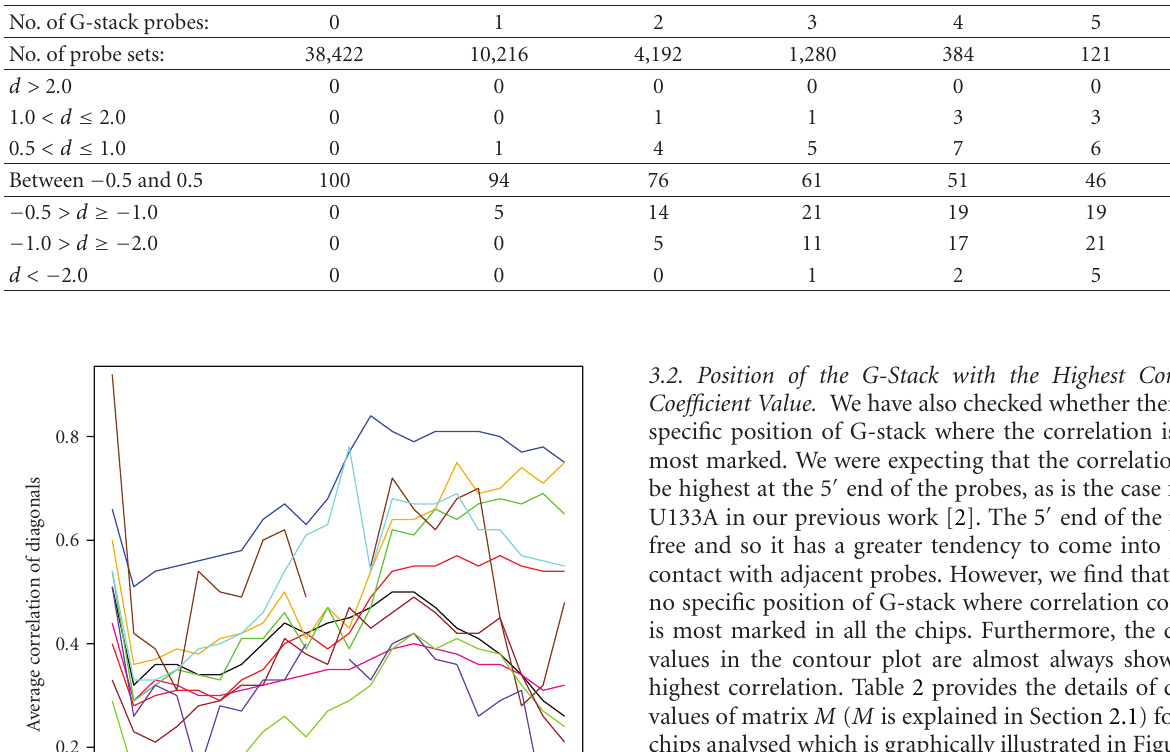
Table 3: The e ff ect on RMA of removing G-stack probes from probe sets. Subtraction of the original RMA value from the RMA value after removal of G-stack probes gives the quantity d . Entries are column percentages.